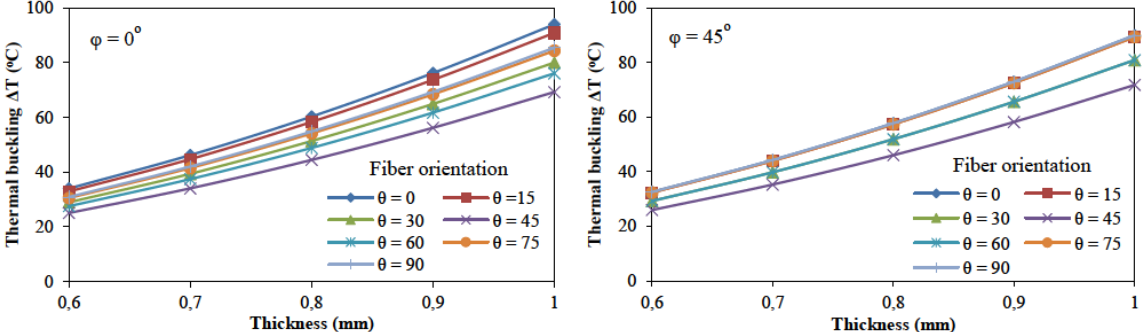
Figure 7: Effect of layer thickness with various fiber orientations.